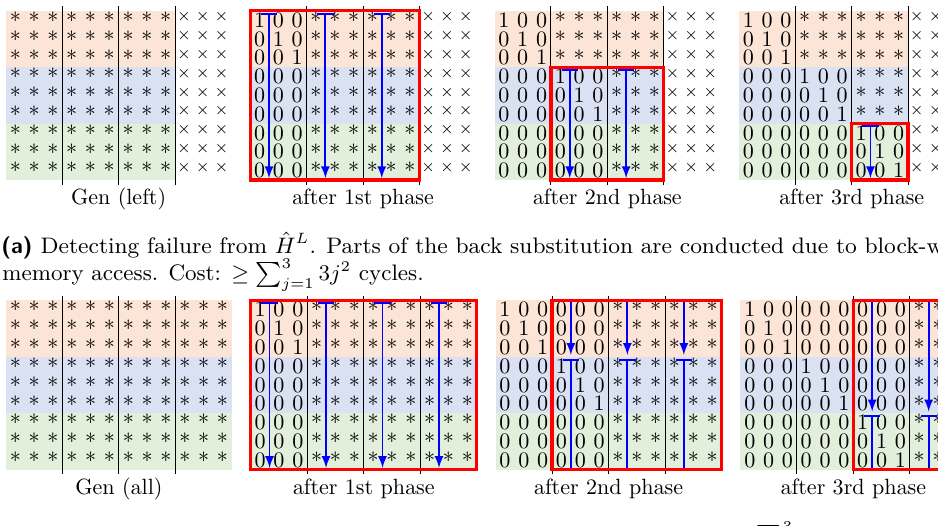
Figure 5: Visualization of HEA for a 9 × 12 matrix using a column-block size of s = 3. Asterisks denote random data. Corresponding sets of rows are marked in the same color. Red boxes show which matrix parts have been computed. ‘Gen (left)’ denotes only ˆ H L is generated while ‘Gen (all)’ denotes the same matrix ˆ H is